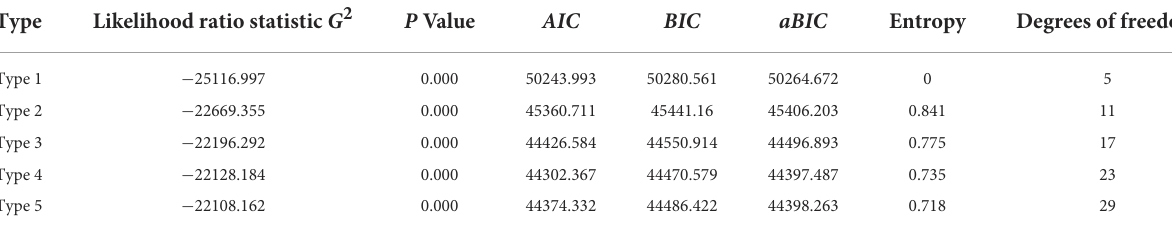
TABLE 2 Latent category model indicator evaluation of internet use categories.